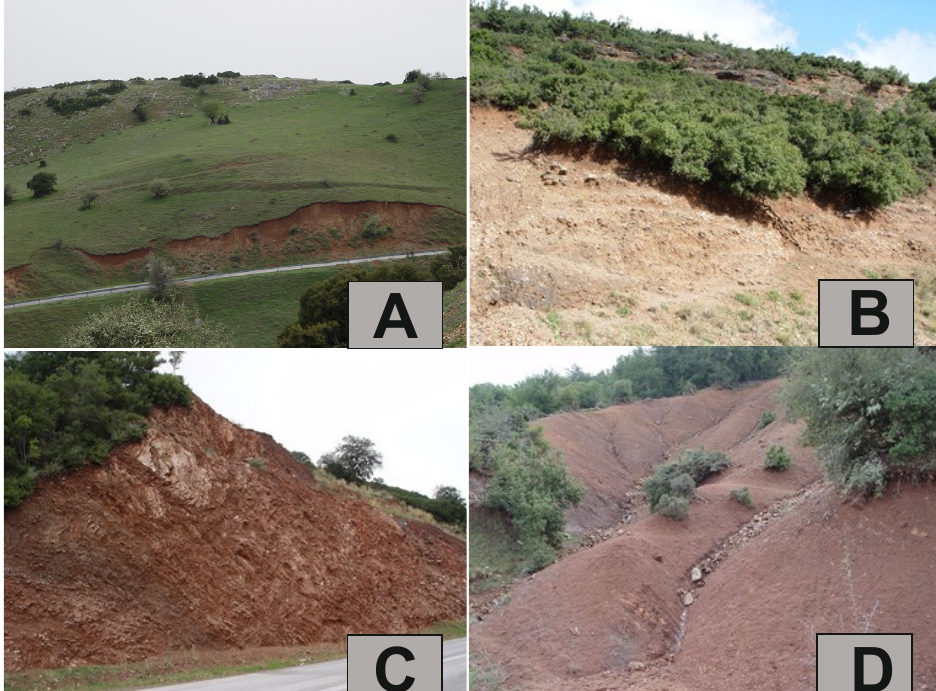
Figure 3. ( A ): Transition from radiolarites to terra rossa, on the regional road network Aigio— Fteri—Petsaki, Prefecture of Achaia, ( B ): Plio-Pleistocene conglomerates between the settlements Lagadi—Kalanistra, ( C ): Radiolarites before the settlement Kataraktis, ( D ): Radiolarites in the area Rachi Striglou, Panachaiko mountain.